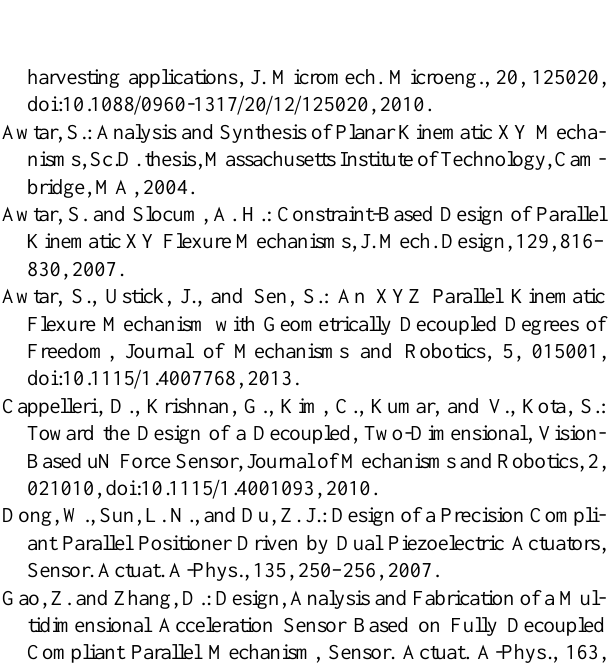
Figure 10. Workspace of the variation in Octant I of the coordinate system